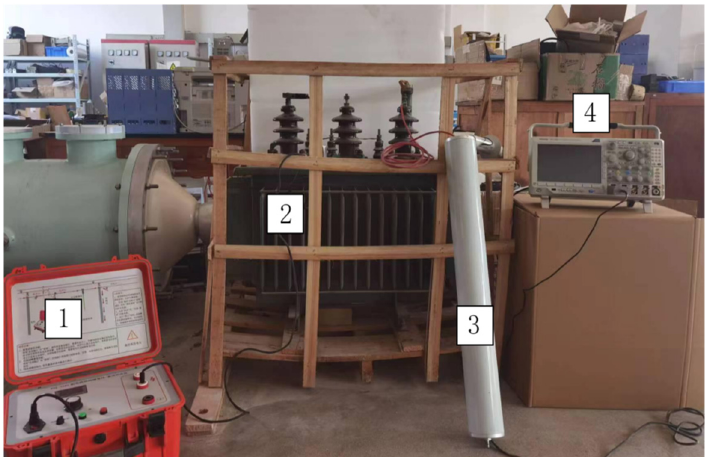
Figure 17. Experimental platform. (1) Pulse signal generation device, (2) transformer device, (3) non-inductive resistor, and (4) oscilloscope.